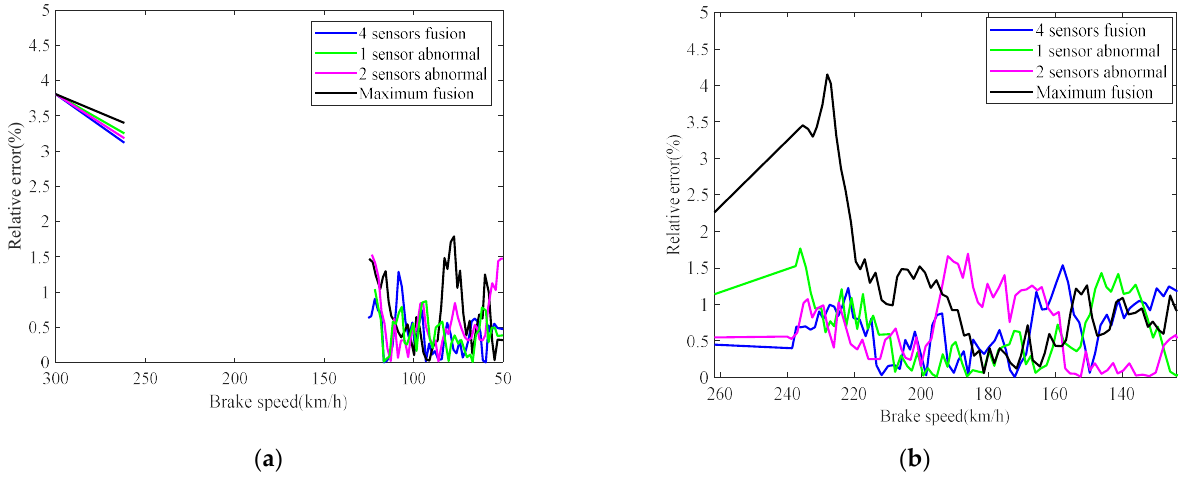
Figure 17. Identification relative errors of friction coefficient and adhesion coefficient: ( a ) friction coefficient; ( b ) adhesion coefficient.